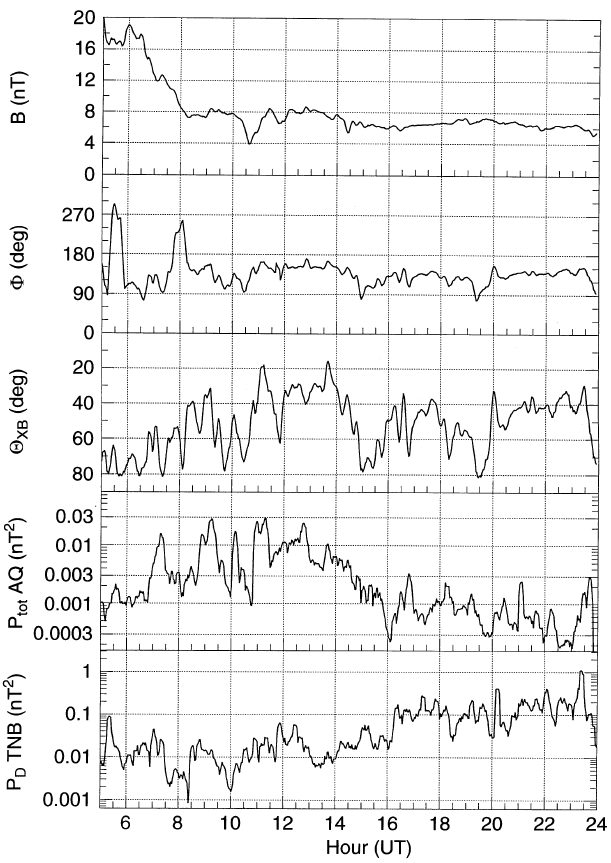
Fig. 1. Interplanetary magnetic field parameters ( from the top: magnitude, longitude and cone angle), Pc3 power at AQ (H+D) and TNB (D component) for the time 0500–2400 UT on January 11, 1997. Powers have been computed by taking into account